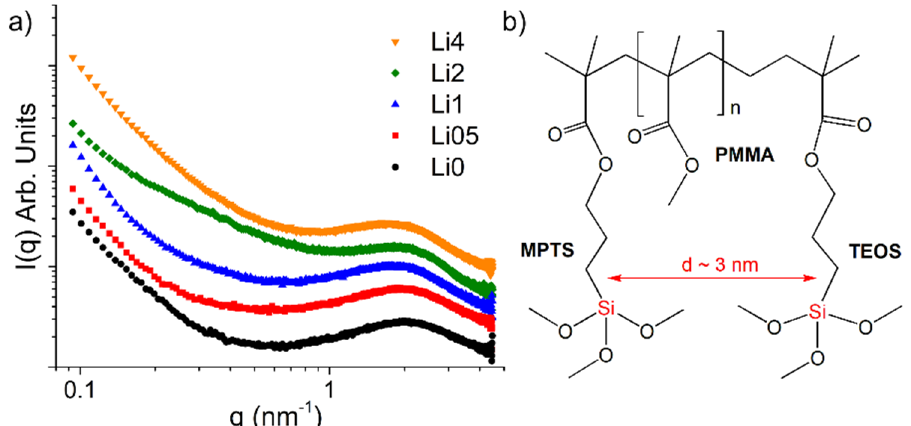
Figure 3. ( a ) SAXS intensity profiles of hybrids prepared with different concentrations of lithium and ( b ) representative molecular structure for PMMA–silica hybrids highlighting the average distance between the silica domains.